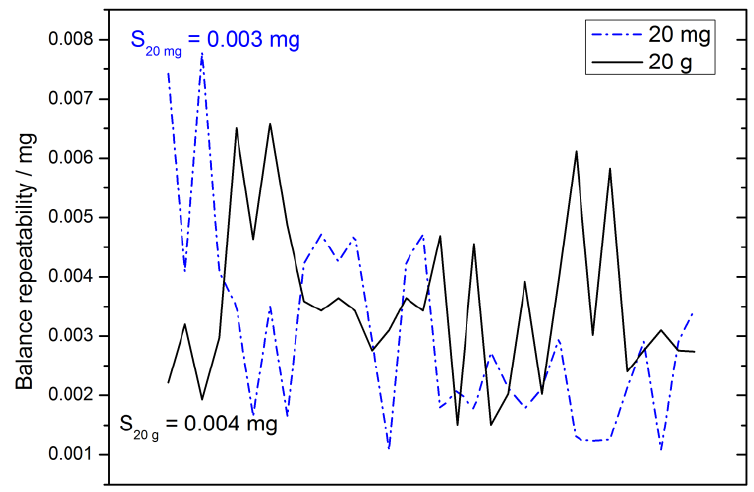
Figure 11. Repeatability variations in 20 mg and 20 g.